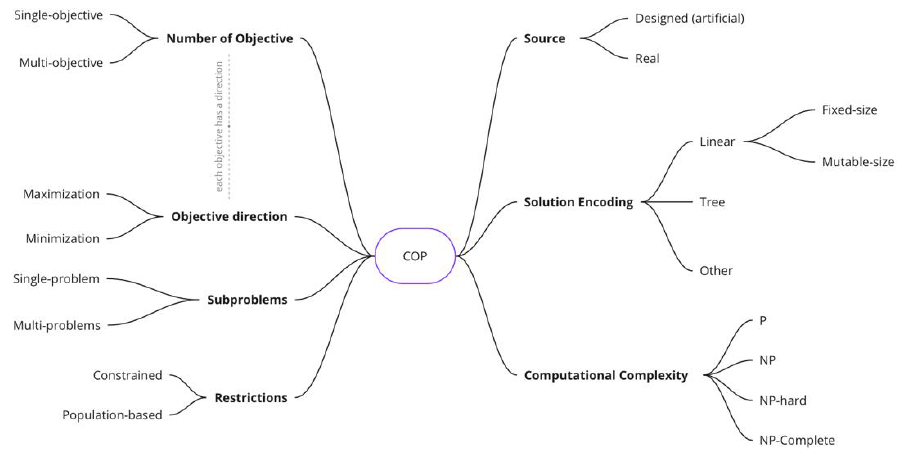
Figure 1. Combinatorial optimization problem — building blocks .